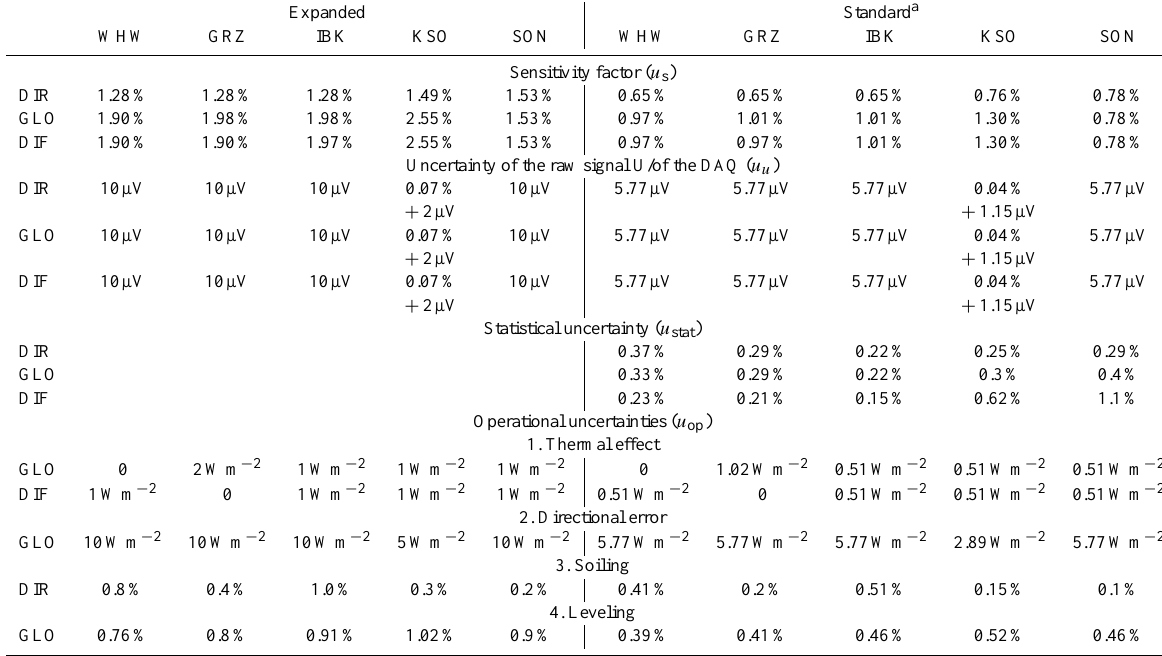
Table 4. Contributions to uncertainties affecting shortwave measurements at all five ARAD stations in the period 1 July 2014 to 30 June